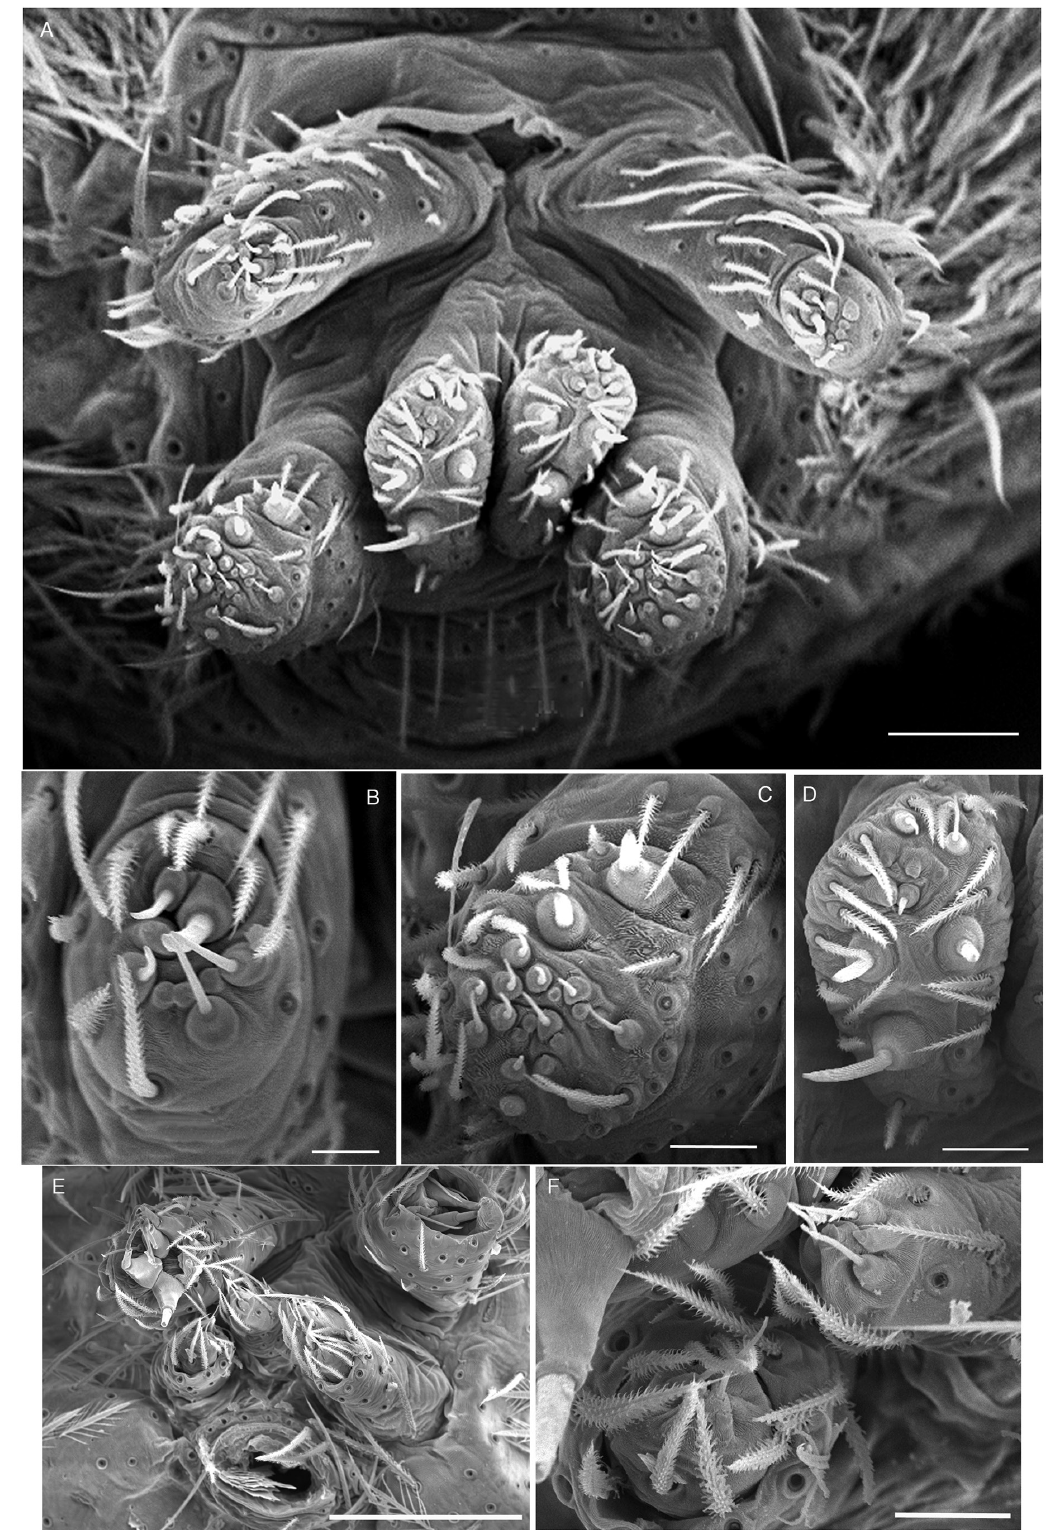
Fig. 7. Cteniogaster hexomma sp. nov. A-D. ♀. A. Spinnerets, posterior view. B. ALS. C. PLS. D. PMS. E-F. ♂. E. Spinnerets, posterior view. F. PLS + PMS. Scale bars: A, E-F = 50 μm; C-D = 20 μm; B = 10